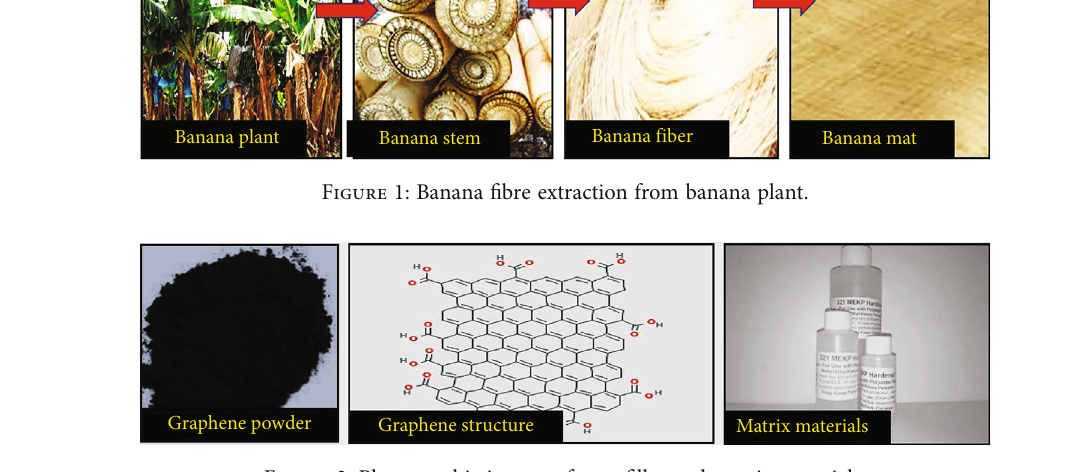
Figure 2: Photographic images of nano fi ller and matrix materials. Table 1: Parameters and their levels for hybrid composite.